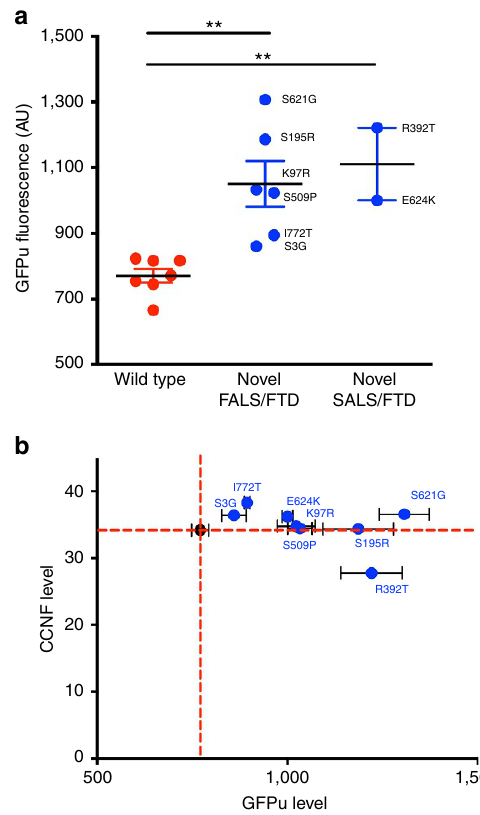
Figure 2 | Mutant cyclin F impairs ubiquitin-mediated proteasomal degradation. NSC-34 cells were co-transfected with GFP u and either wild type or mutant cyclin F, tagged with mCherry. GFP u fluorescence intensity was analysed by flow cytometry 48h post transfection. ( a ) Plot of GFP u fluorescence intensity following flow cytometry. A significantly higher level of GFP u fluorescence was observed in cells expressing novel cyclin F mutations (blue data points) when compared with those expressing wt CCNF (red data points) WT v FALS/FTD P ¼ 0.0017, d.f. ¼ 11; WT v SALS/ FTD P ¼ 0.001, d.f. ¼ 7; two-tailed unpaired Student’s t -test). ( b ) The higher level of GFP u fluorescence was independent of the level of cyclin F as quantified using mCherry signal—R-squared ¼ 0.13. Red dashed lines represent the WTmean. Data are represented as mean, ± s.e.m. n ¼ 3 ( n is one experiment consisting of the mean of 50,000 cells); ** P o 0.01. d.f., degrees of